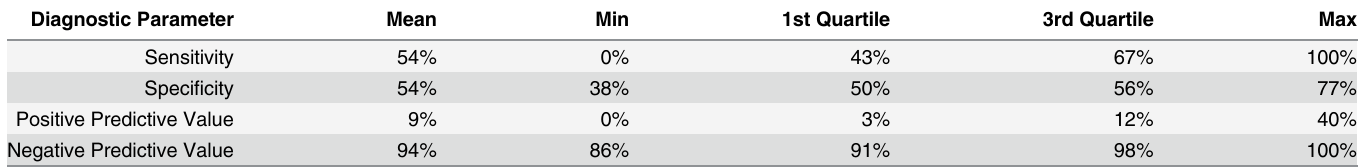
Table 7. Summary statistics for the quality of air pressure change as an early warning system for each of the 56 patients. Diagnostic